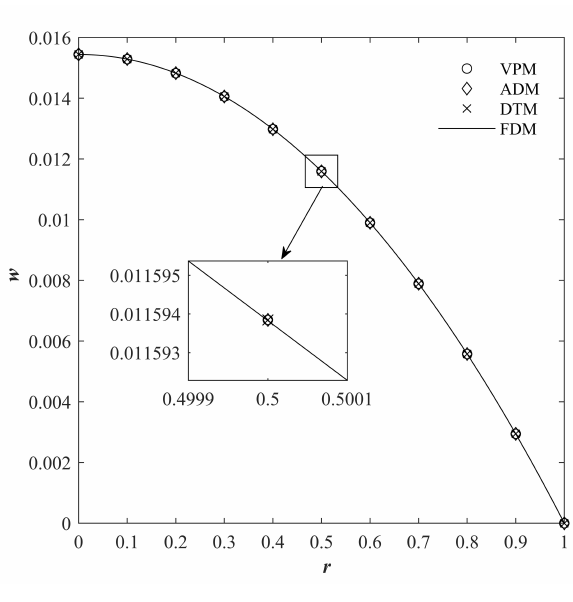
Fig. 6: Comparison of the solutions to equation (40) using all meth- ods